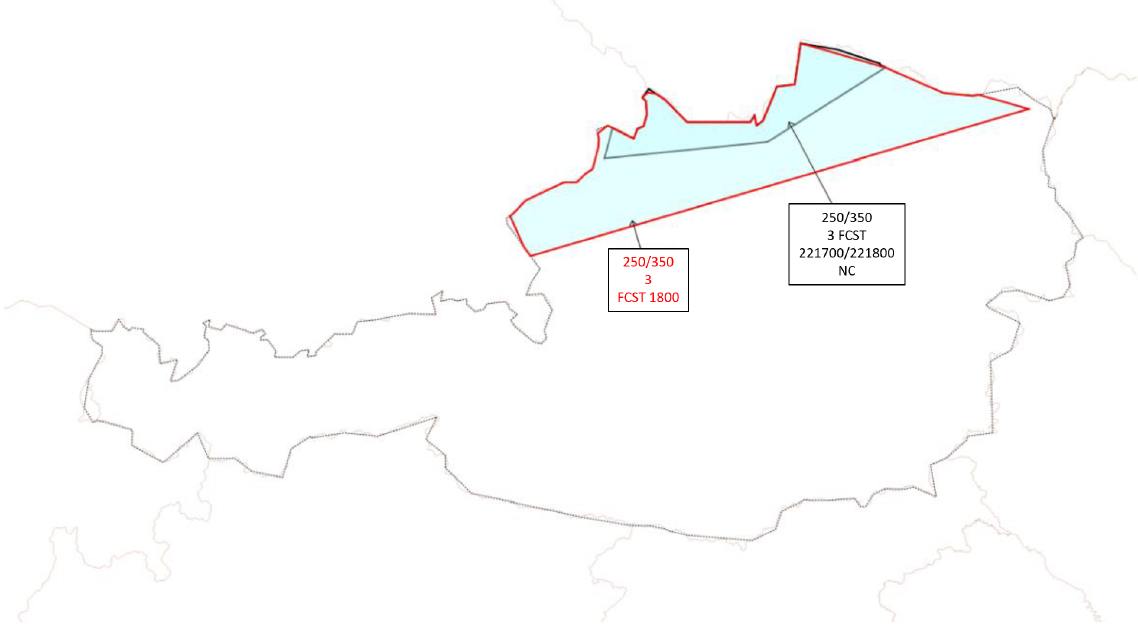
Figure 11. Location of the two polygons for which the SIGMETs (ACG) were issued.